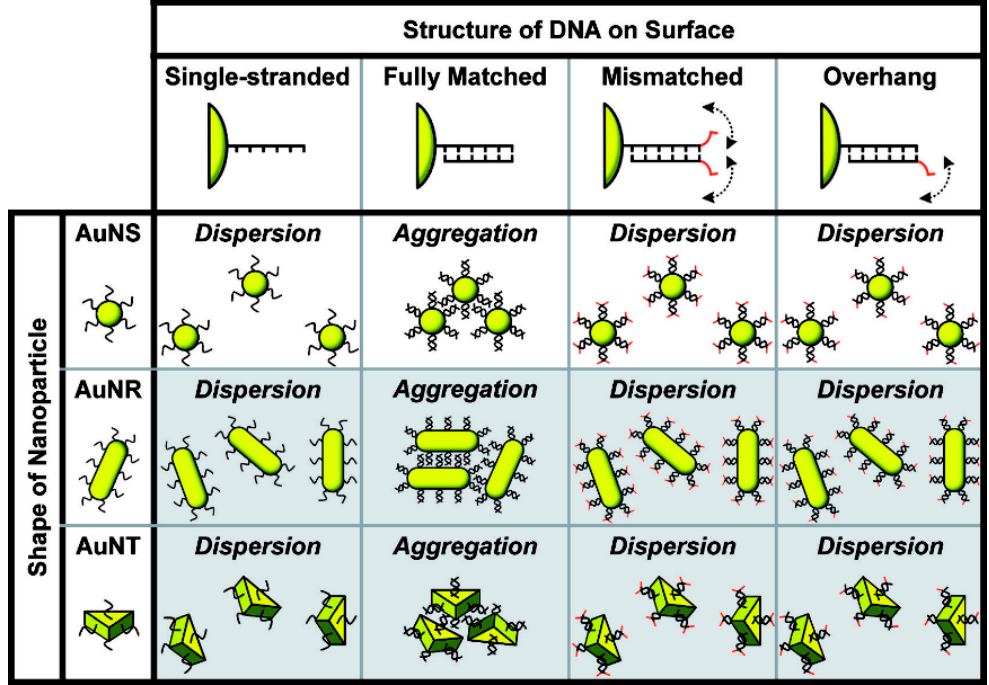
Figure 4. The different colloidal behaviors of ssDNA-labeled gold nanospheres, nanorods (AuNRs), and nanotriangles in a moderately high ionic strength medium. Double-headed arrows indicate unpaired mononucleotides. Reproduced with permission from Reference [68]. Wiley, 2015.